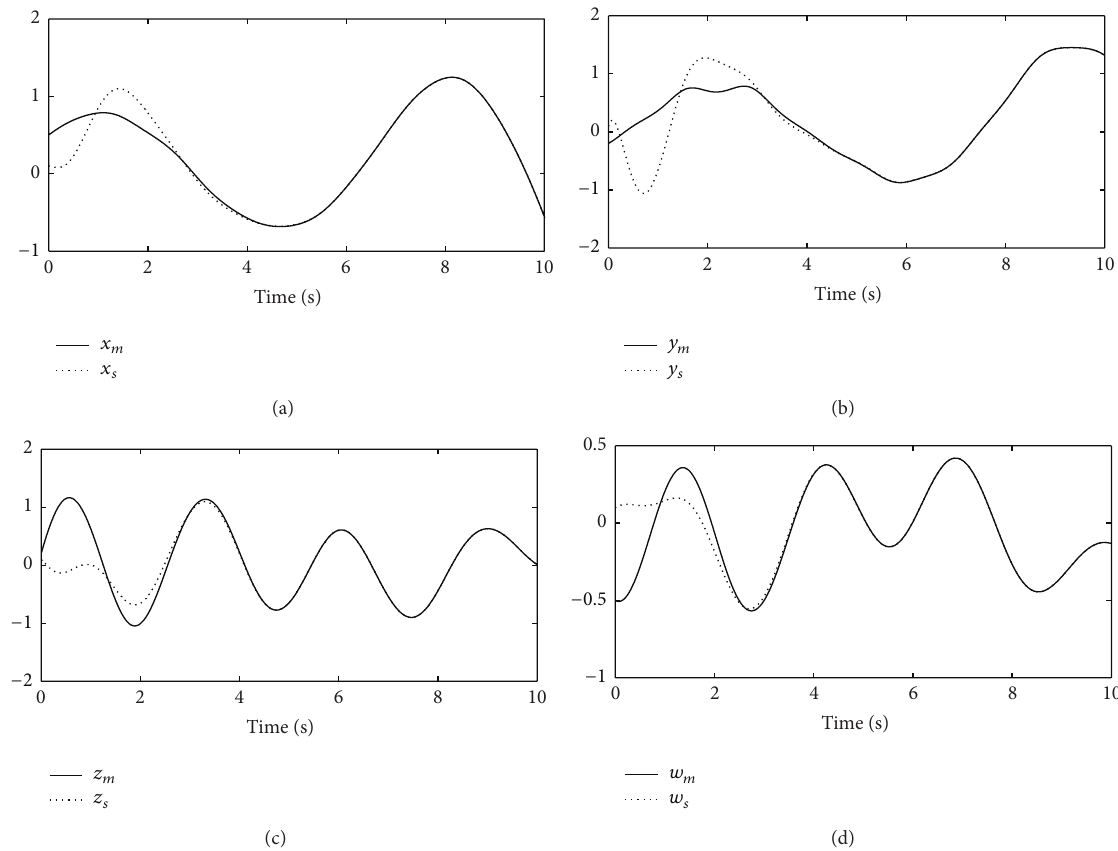
Figure 4: State responses of controlled drive and response systems: (a) state response of 𝑥 𝑚 , 𝑥 𝑠 ; (b) state response of 𝑦 𝑚 , 𝑦 𝑠 ; (c) state response of 𝑧 𝑚 , 𝑧 𝑠 ; (d) state response of 𝑤 𝑚 , 𝑤 𝑠